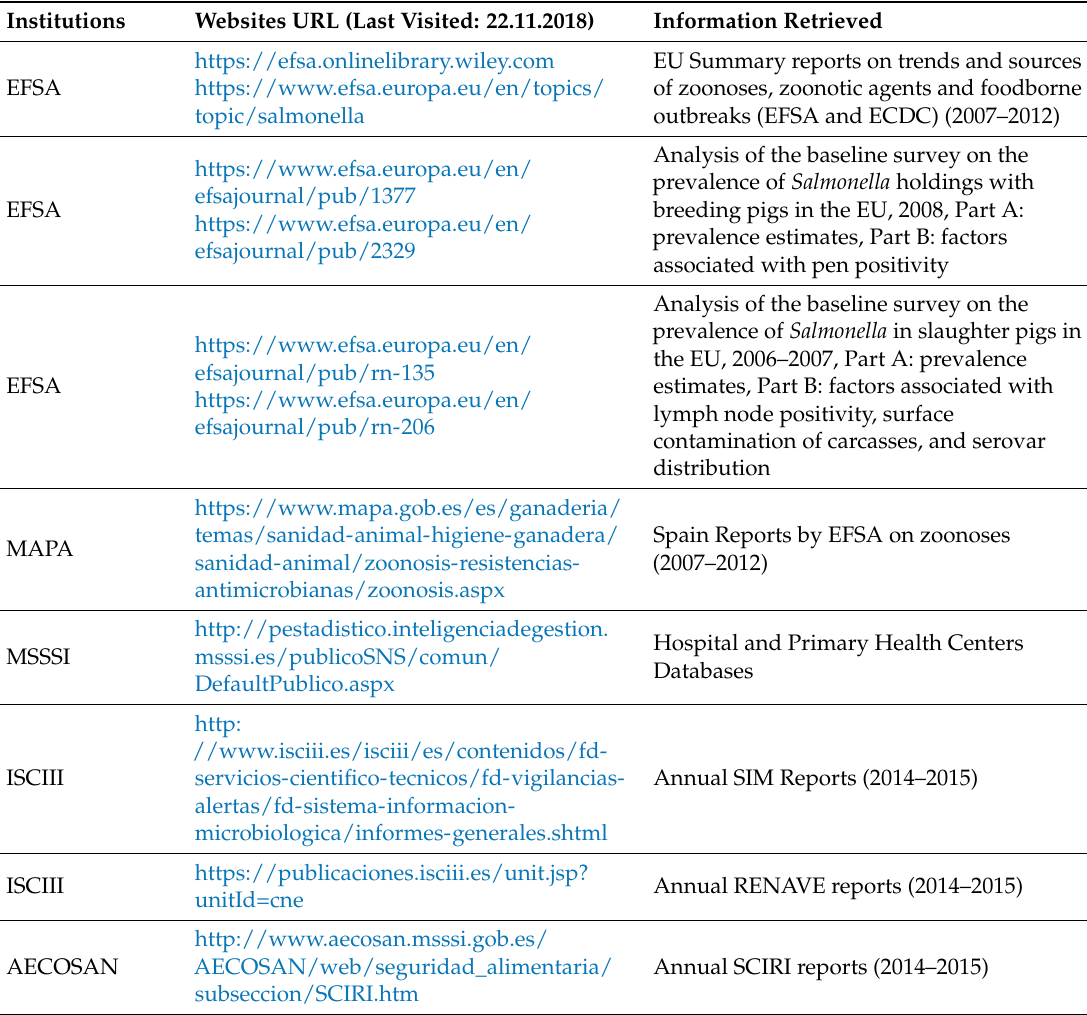
Table 2. Institutional websites with information on swine-related Salmonella relevant for Spain. Institutions